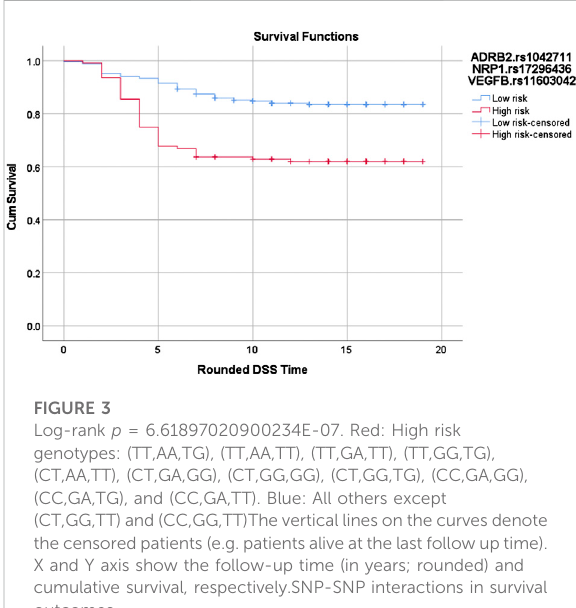
FIGURE 3 Log-rank p = 6.61897020900234E-07. Red: High risk genotypes: (TT,AA,TG), (TT,AA,TT), (TT,GA,TT), (TT,GG,TG), (CT,AA,TT), (CT,GA,GG), (CT,GG,GG), (CT,GG,TG), (CC,GA,GG), (CC,GA,TG), and (CC,GA,TT). Blue: All others except (CT,GG,TT) and (CC,GG,TT)The vertical lines on the curves denote the censored patients (e.g. patients alive at thelast follow up time). X and Y axis show the follow-up time (in years; rounded) and cumulative survival, respectively.SNP-SNP interactions in survival